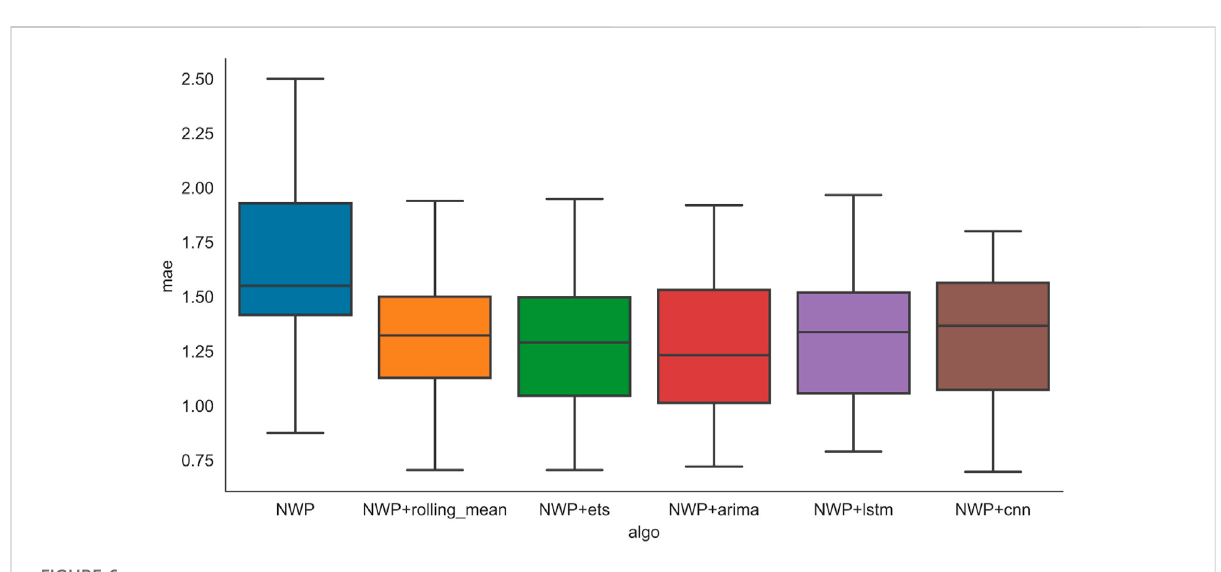
FIGURE 6 Overall mae results based on the